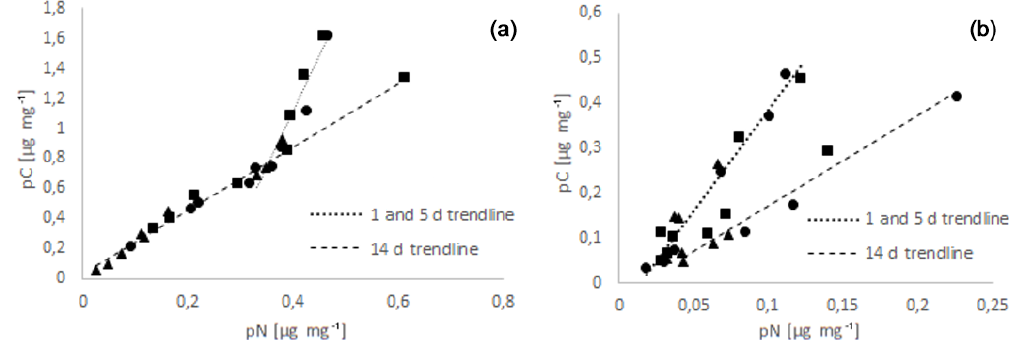
Figure 2. Relationship between food N uptake (pN) and food C uptake (pC) for A. tepida (a) and H. germanica (b) for the time windows day 1 to 5, and day 14. Regressions were run separately for these time windows. The triangles correspond to the values at 11 PSU, the circles to those at 24 PSU, and the squares to the values at 37